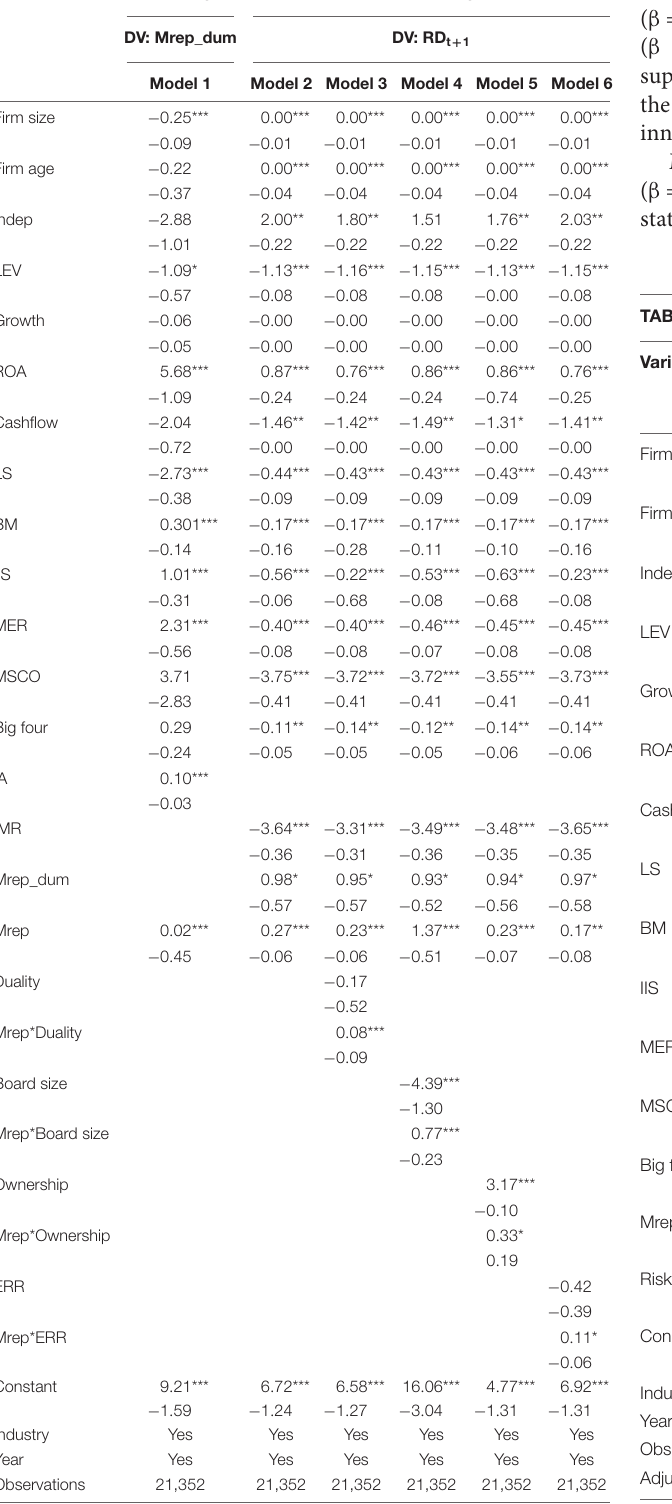
TABLE 4 | Managerial reputation, corporate governance, and innovation investment usage.